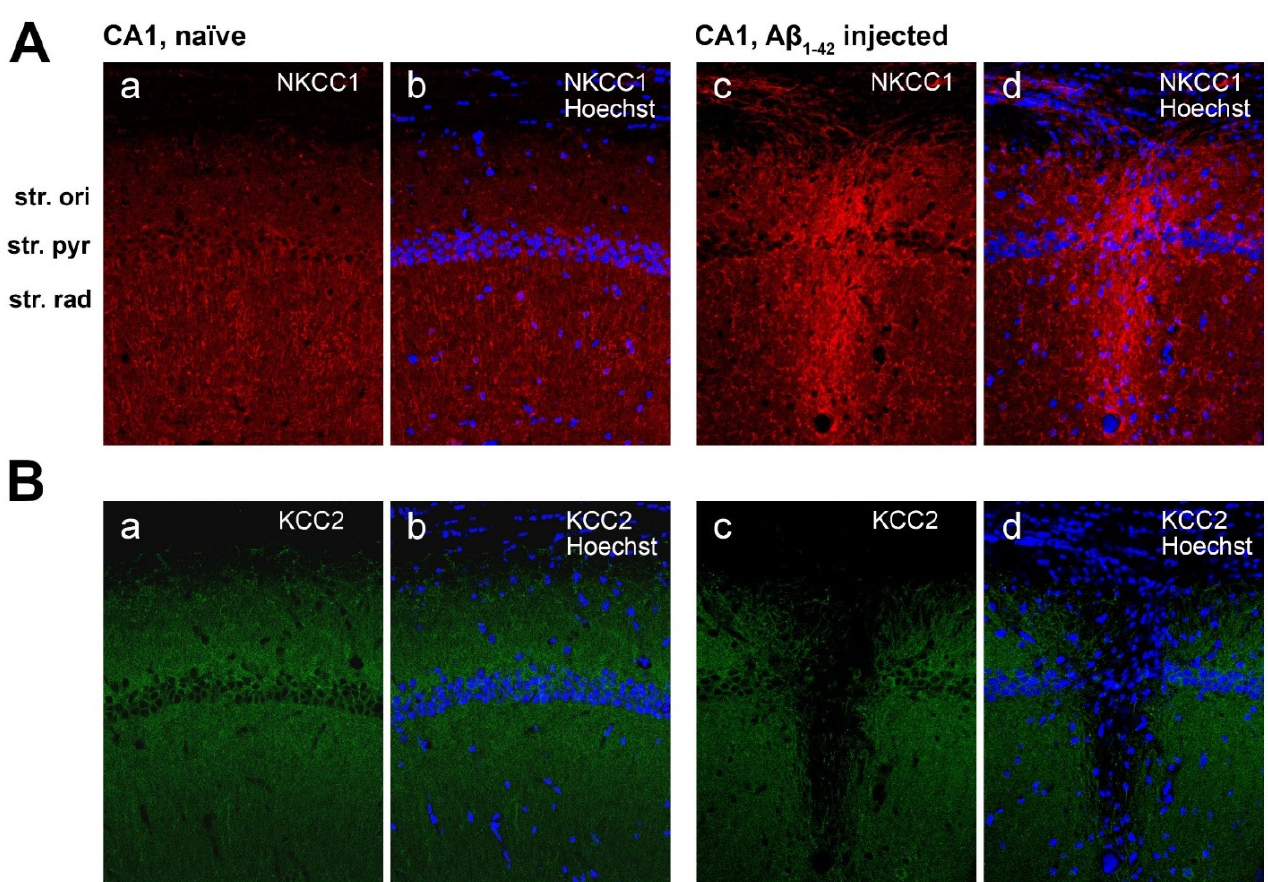
Figure 8. NKCC1 and KCC2 expression in the CA1 region of naïve and A β 1-42 -treated mice. ( A ) NKCC1 (red) and Hoechst (blue) staining in naïve mice ( a , b ) and A β 1-42 -injected mice, showing the injection site ( c , d ). ( B ) KCC2 (green) and Hoechst (blue) staining in naïve ( a , b ) and A β 1-42 -injected mice, showing the injection site ( c , d ). Scale bar = 50 µ